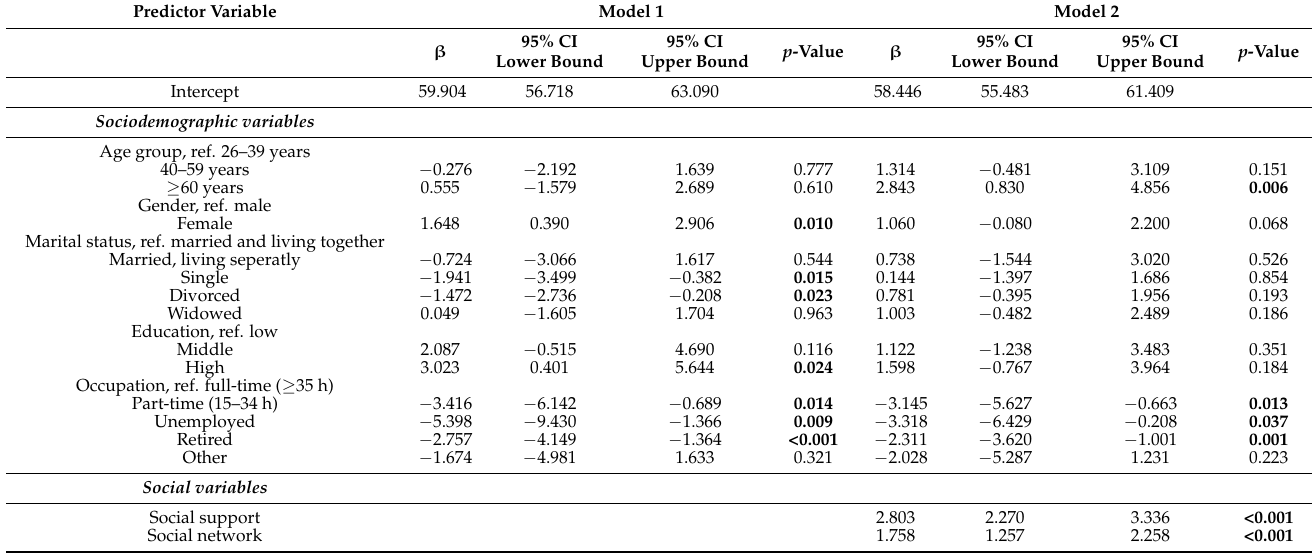
Table 3. Results of the multiple linear regression analyses 1